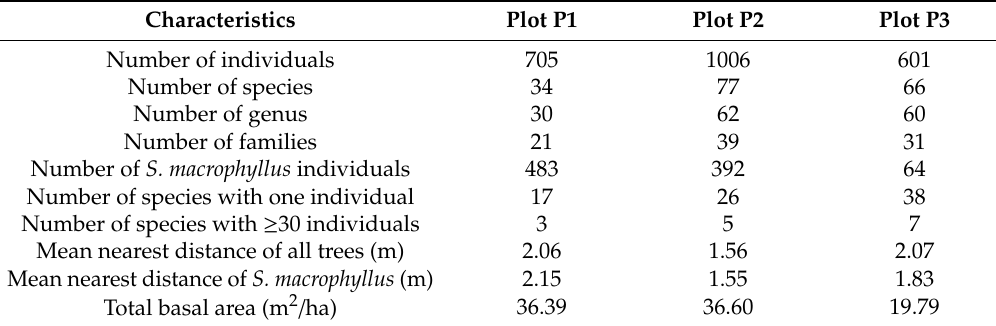
Table 1. The characteristics of the three sample plots.